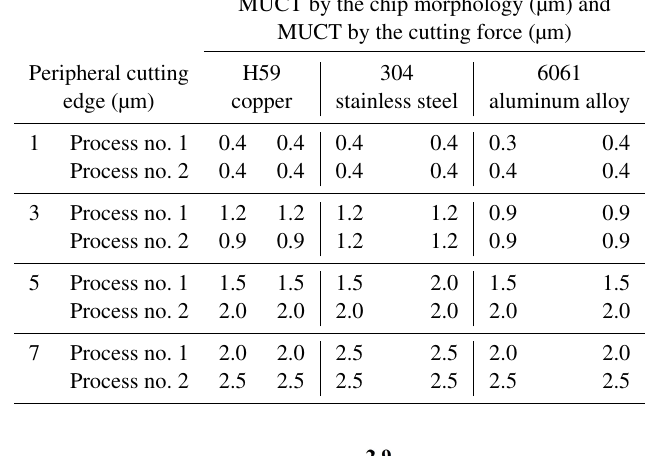
MUCT by the chip morphology (µm) and MUCT by the cutting force (µm)